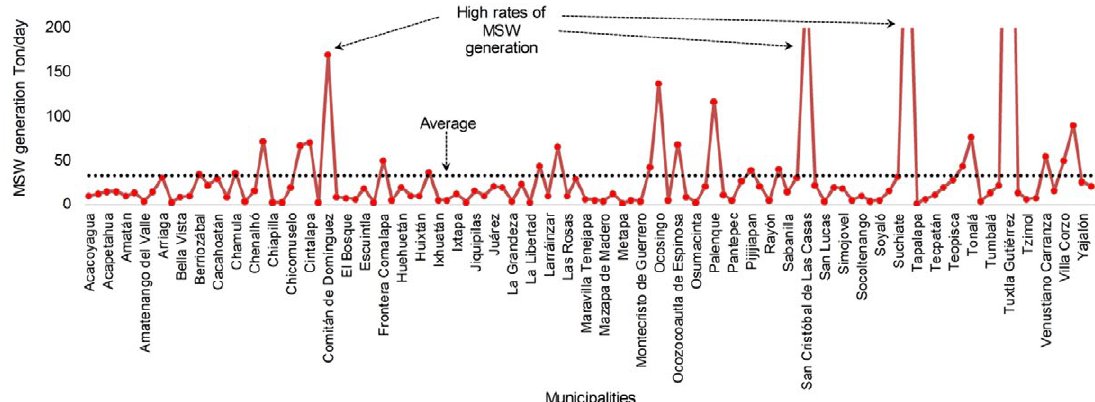
Fig. 2: MSW generation rates in the state of Chiapas